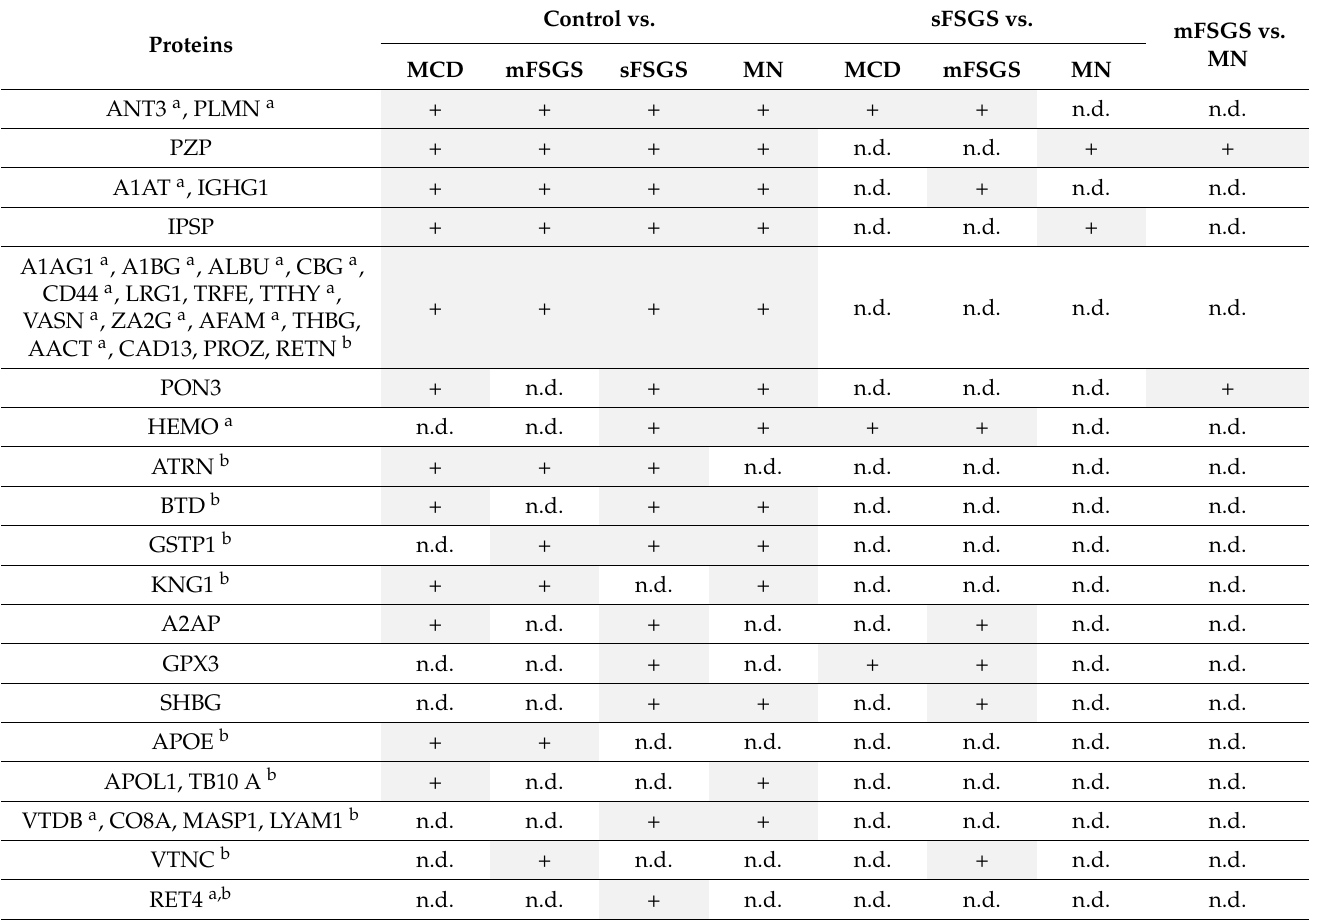
Table 1. The 40 significantly different urinary core proteins identified in all studied groups.